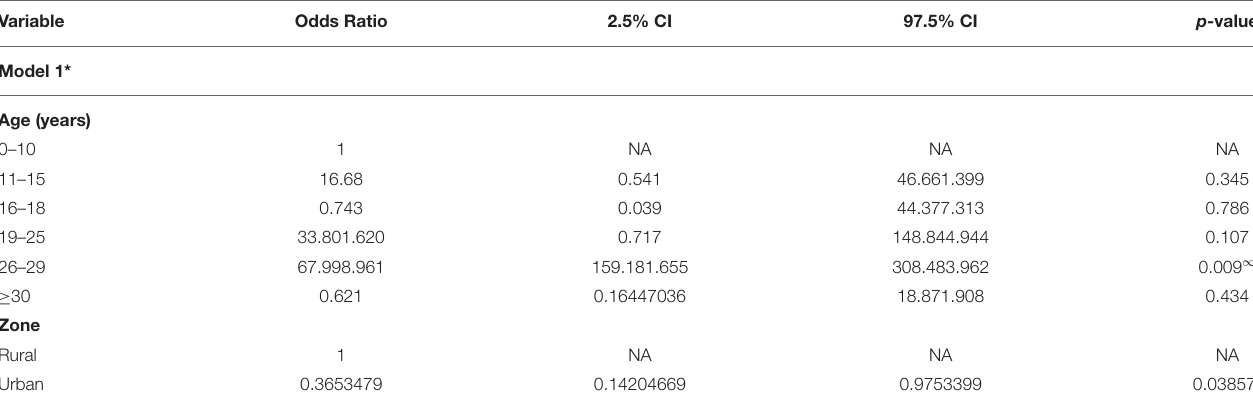
TABLE 2 | Model results of association between post-exposure rabies treatment drop-out and socio-demographic and economic characteristics of rabies victims in rural and urban areas with 95% Confidence Interval (CI) and p- value. Variable Odds